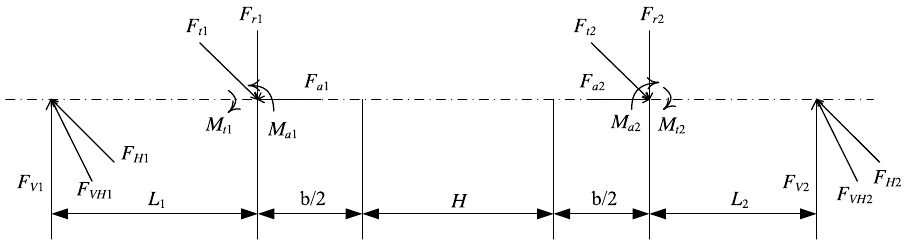
Fig. 4. Force analysis of double helical gear shaft.